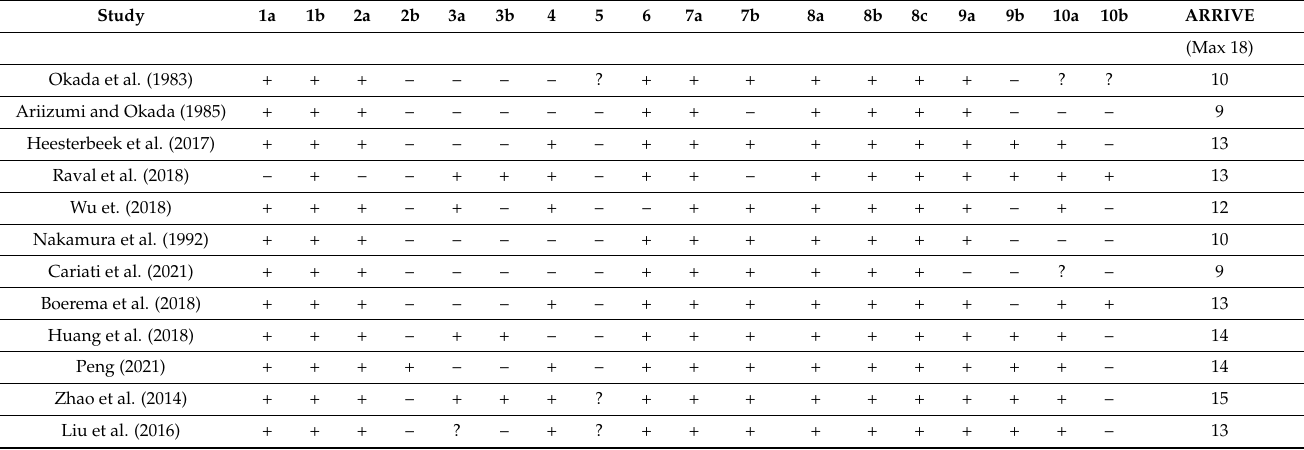
Table A3. Quality assessment of animal studies included for qualitative